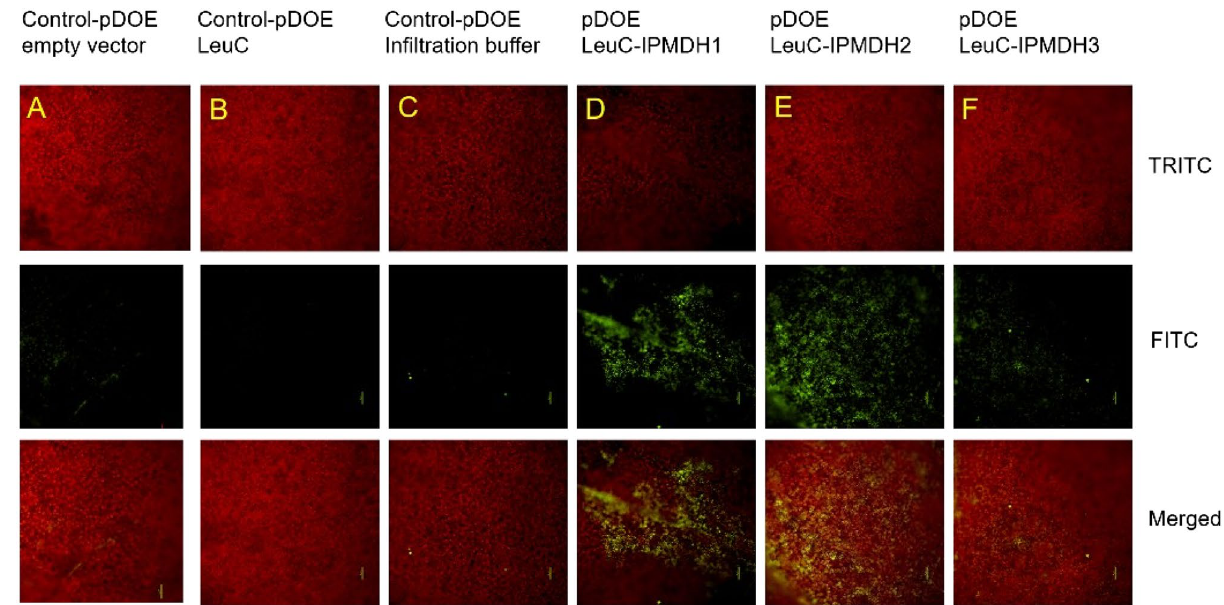
Figure 3. BiFC of the interaction between LeuC and IPMDHs using the pDOE–mVenus210 system. Nicotiana benthamiana leaves were agroinfiltrated at an optical density of 0.4 and imaged at Day 3. Scale bars = 100 µm. The chlorophyll autofluorescence was detected with the TRITC filter cube (excitation filter: 527.5–565, barrier filter: 577.7–632.5) (top panel), the mVENUS fluorescence was detected using the FITC filter cube (excitation filter: 465–495, barrier filter: 515–155) (middle panel), and the merged images of TRITC and FITC at the bottom panel. ( A ) NmVen210–X:CVen210 empty vector showing background signal; ( B ) LeuC:NmVen210–X:CVen210 vector showing background signal; ( C ) Infiltration buffer control showing background signal; ( D ) LeuC:NmVen210 interacting with IPMDH1:CVen210; ( E ) LeuC:NmVen210 interacting with IPMDH2:CVen210; (F) Weak interaction between LeuC:NmVen210 and